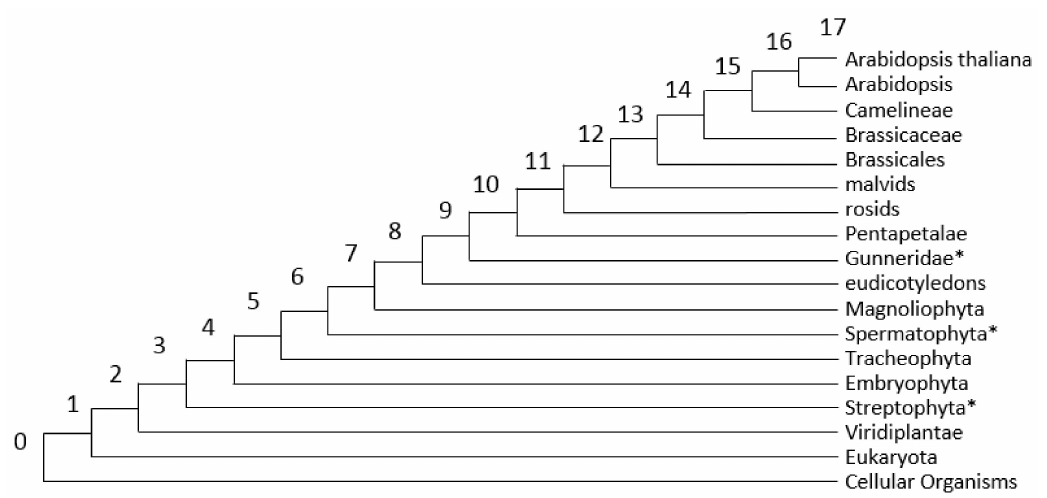
Figure1. Thephylostratigraphicmapof A.thaliana andphylogenyusedinthesearchfortheevolutionary origin of A. thaliana genes, 18 genomic phylostrata that correspond to the phylogenetic internodes. An asterisk (*) indicates three phylostrata that were excluded from the statistical